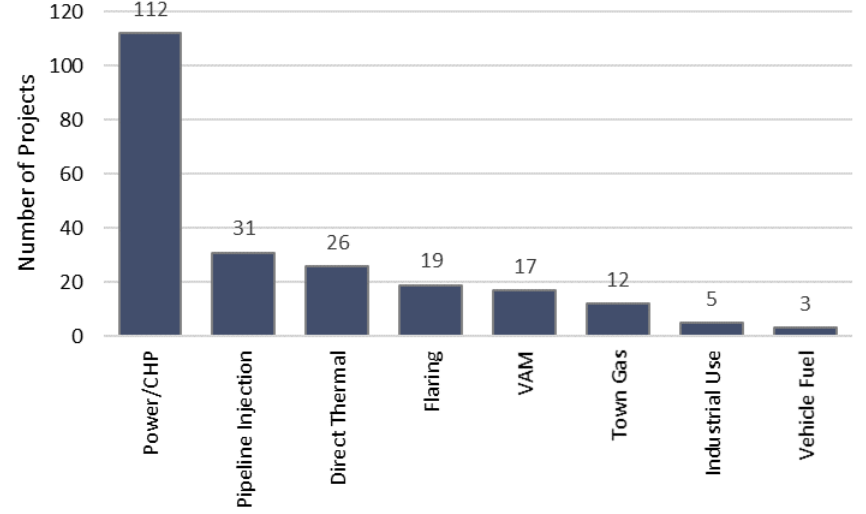
Figure 2. Coal mine methane projects list [21].